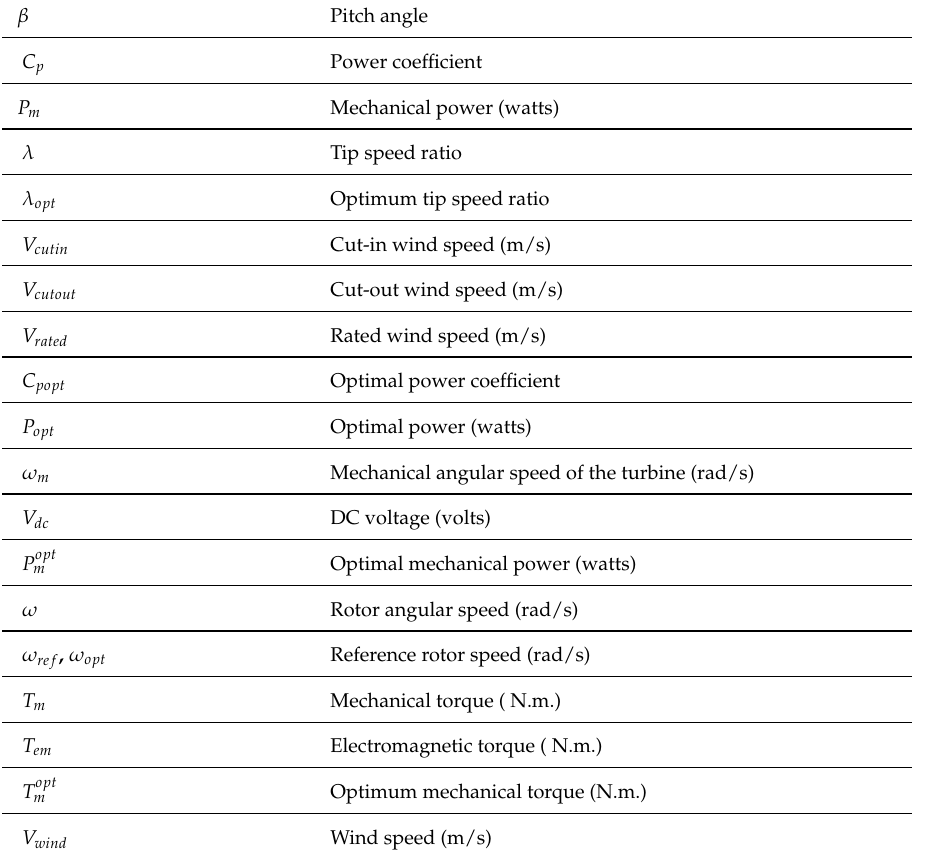
Table 10. List of